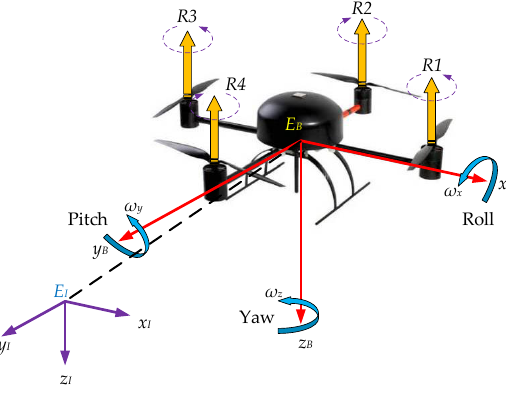
Figure 1. Coordinate systems of the